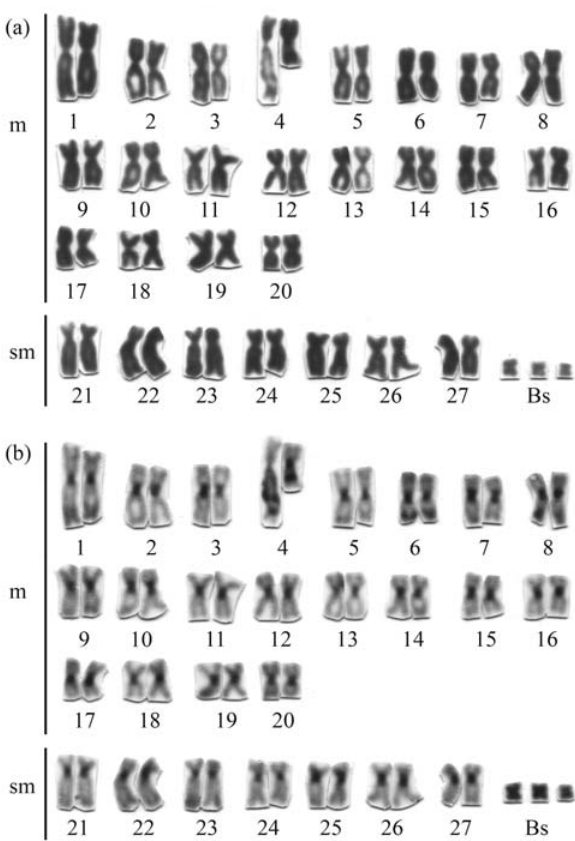
Figure 1 - Karyotypes of Prochilodus lineatus from Dourada Lagoon. (a) standard karyotype with conventional Giemsa staining and (b) karyotype showing C-bands. Bar represents 5 (cid:2)